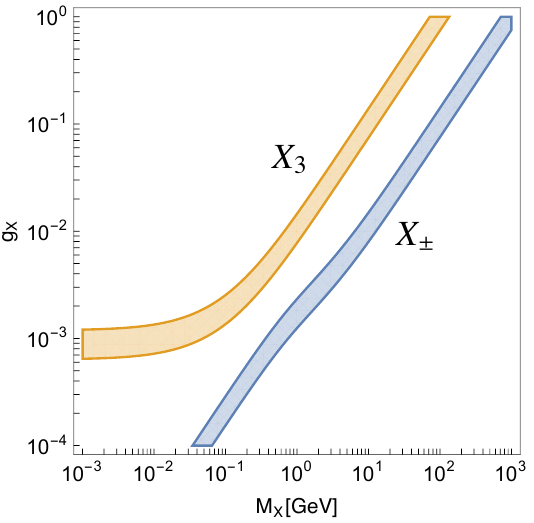
Figure 1 . Parameter space in the ( M X ; g X ) plane preferred by the muon g (cid:0) 2 anomaly at 2 (cid:27)